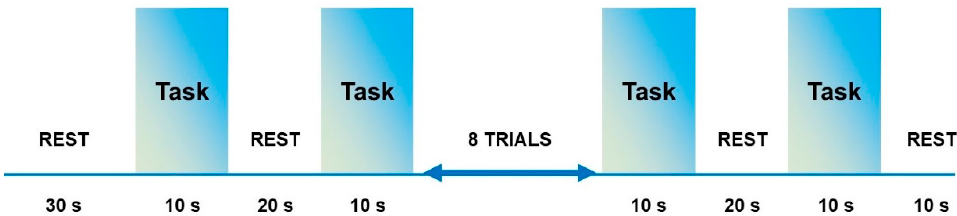
Figure 4. After an initial 30 s rest, each functional near-infrared spectroscopy block consists of 10 s activations and 20 s rests. The total experiment duration for acquiring fNIRS signals is 11 min and includes 12 trials in total.